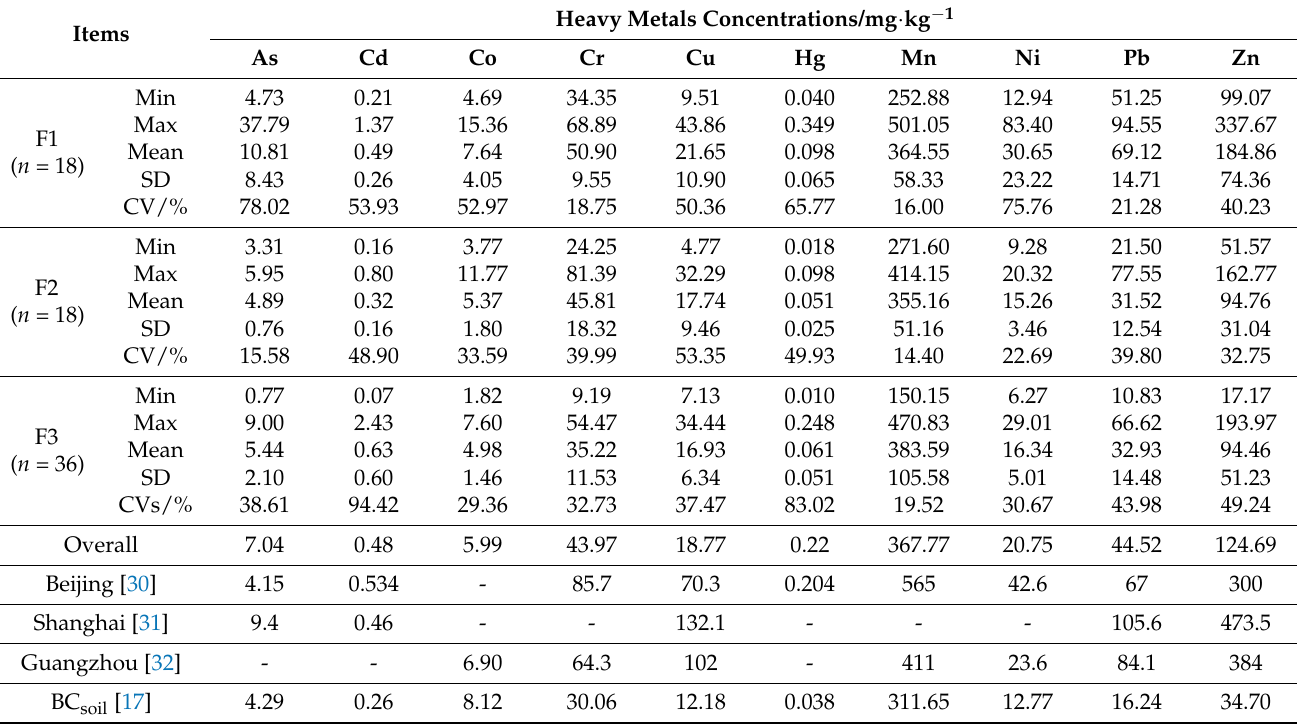
Table 1. Statistical description of the dust heavy metal concentrations around the three factories.